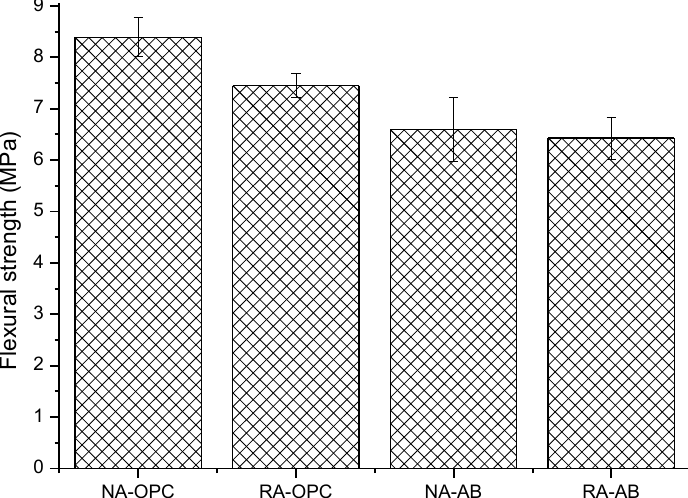
Figure 1. Flexural strength of concrete specimens. Standard deviation is plotted as error